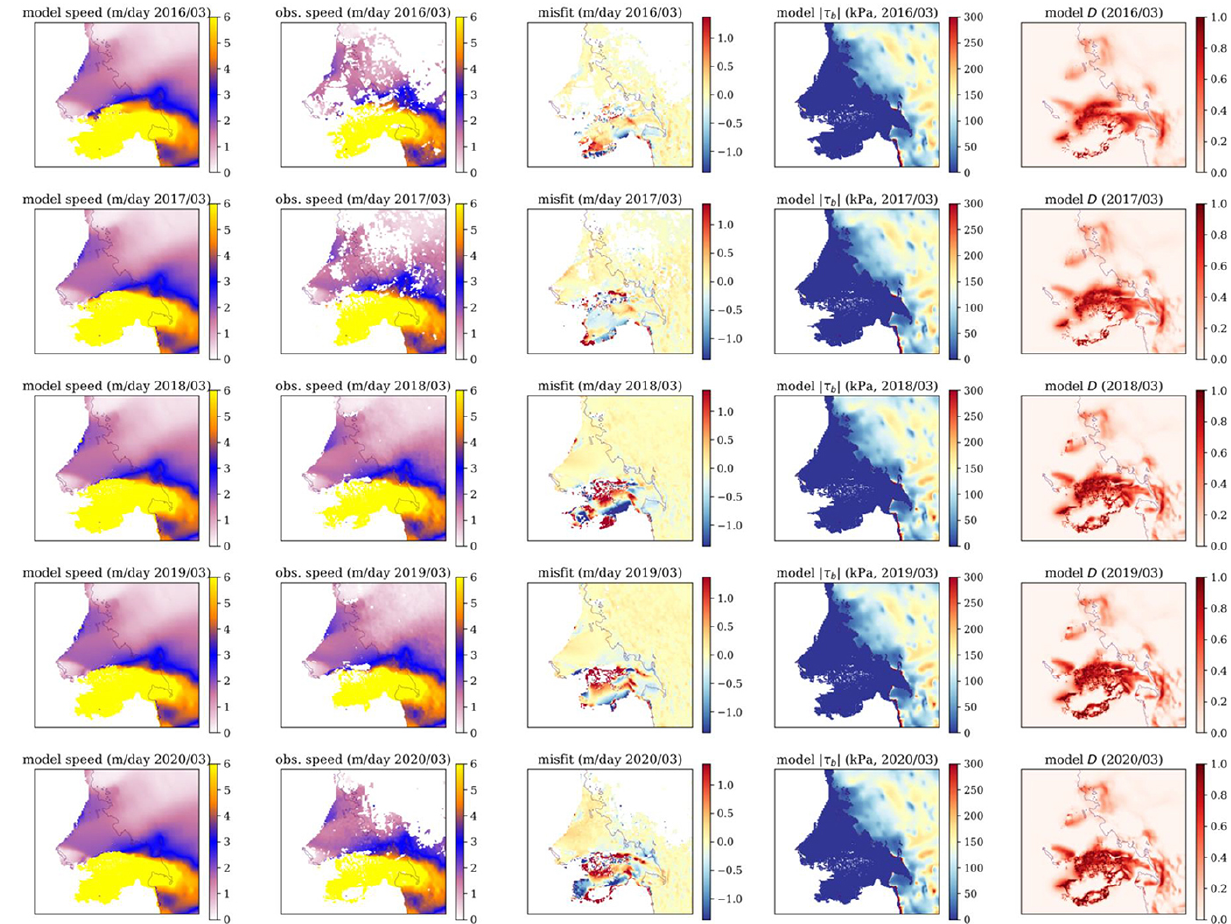
Figure 9. BISICLES inverse problem results: March 2016–2020. The first and second columns show the optimised model velocities and observed velocities; the third column shows the misfit between modelled and observed velocities; and the fourth and fifth columns show the resulting optimised basal traction and damage. Each row shows data for March of